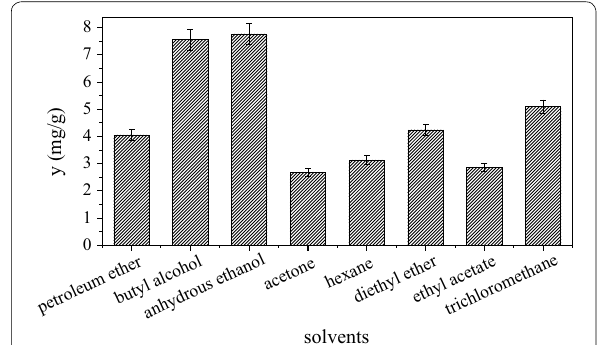
Fig. 3 Effects of extraction solvents on yield of phytosterols from CS